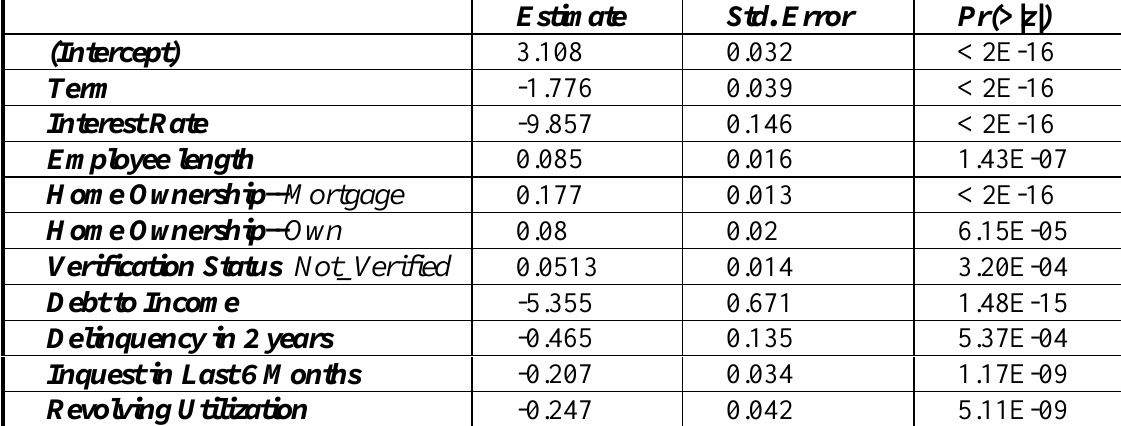
Table 2. Significant features using logistic regression model.